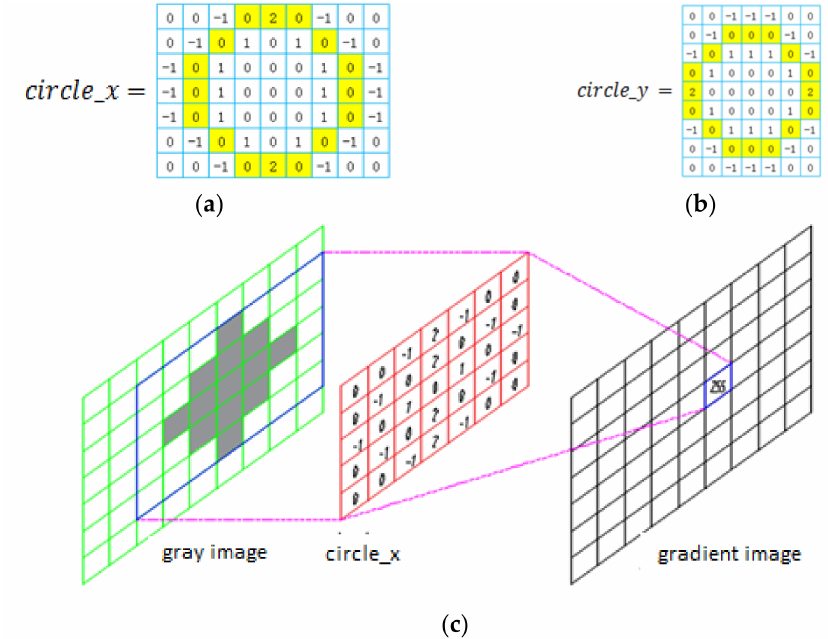
Figure 2. The convolution process use filters which are designed by the features of Roll. ( a ) circle_x filter. ( b ) circle_y filter. ( c ) shows the convolution process, where a gradient image is convolved with the grayscale image and circle_x or